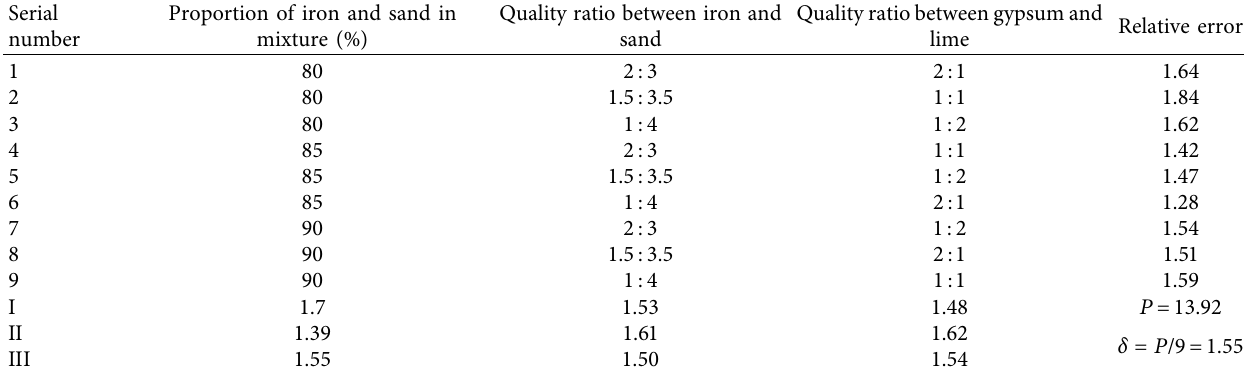
Table 10: Friction angle of relative error analysis.